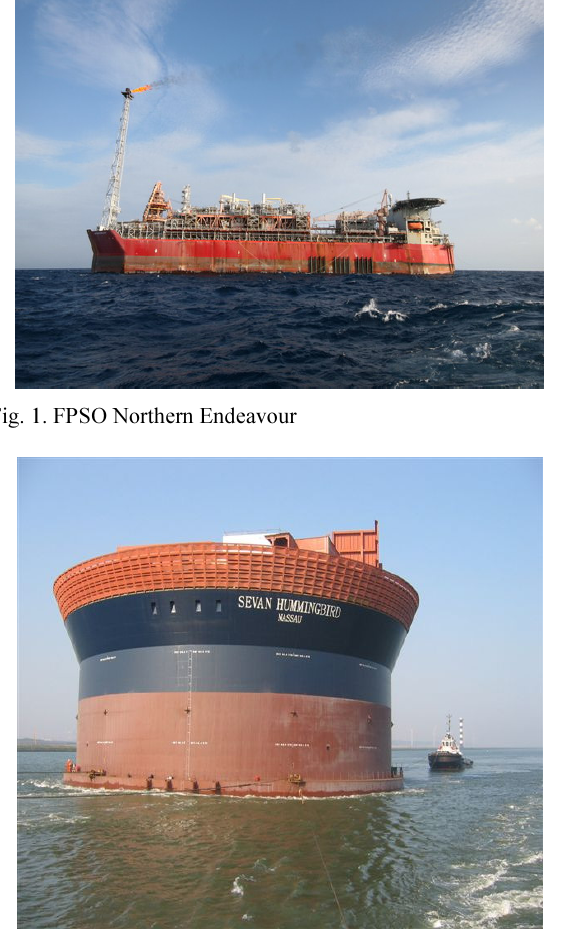
Fig. 2. FPSO Sevan